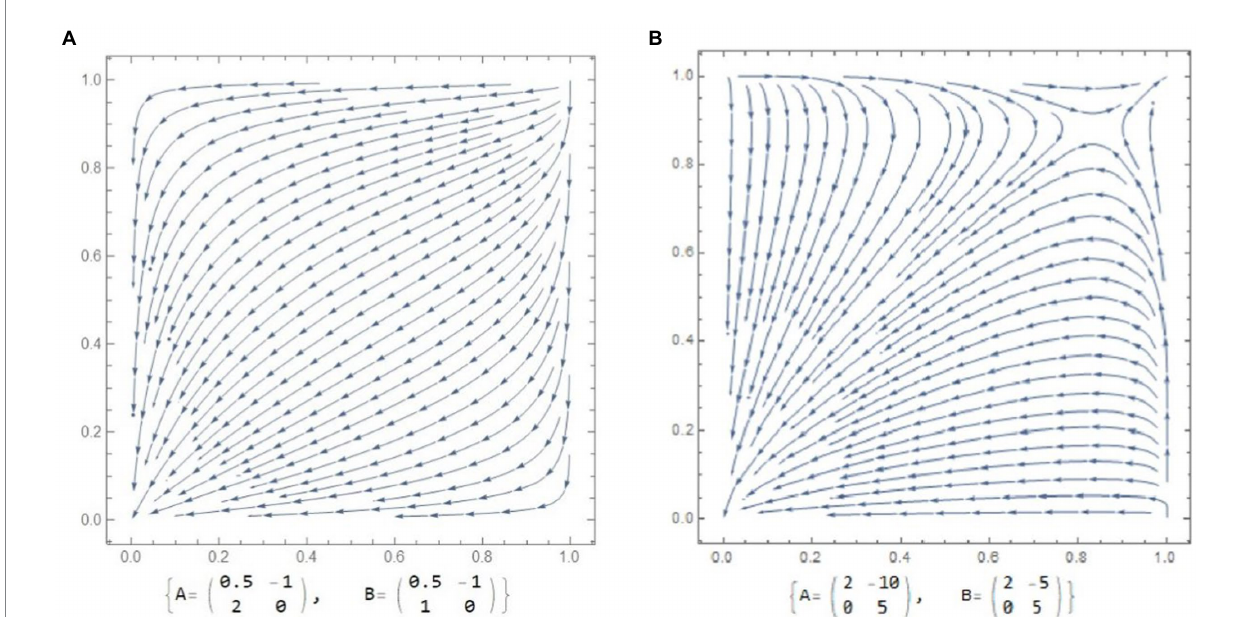
FIGURE 3 Phase portrait and corresponding payoff matrices for males and females. The arrowheads depict evolutionary trajectories. (A) Evolution of care avoidance and mutual reproductive rejection as equilibrium state. Even if the system had started at biparental care, small mutations would have sent it into a state of mutual defection. (B) population is disruptively selected for opposite parenting strategies. This would lead to populations with either exclusively biparental care or populations with a mutual defection strategy (care